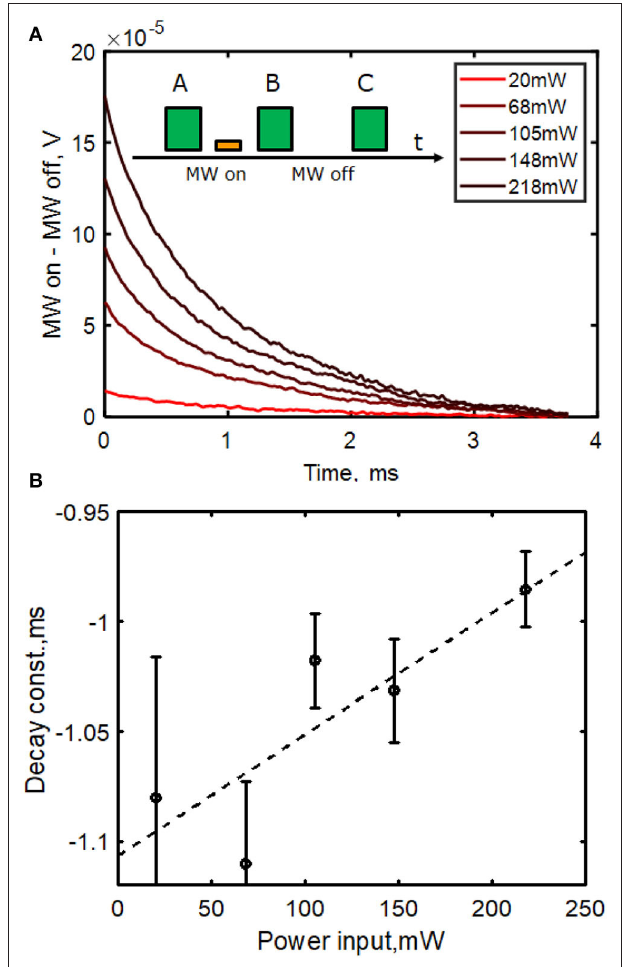
FIGURE 5 | (A) Difference in fluorescence vs. readout pulse time (B,C). The system is initialized with a laser pulse A. Before B a 680 ns π microwave pulse is applied (MW on) and before C, no MW pulse is applied (MW off). The difference in photodetector output voltage during these two pulses as a function of time was measured and the difference is plotted in the figure (MW on-MW off, V). Data is taken at a range of pump laser powers from a Gaussian beam of waist 200 µ m incident at Brewster’s angle. (B) Fitting to an exponential with error estimates based on readout noise. Typical decay length was 1 ms, reducing with higher pump power. This long readout time restricts field sensing bandwidth to 250 or 83 Hz for a 3 pulse, common mode noise mx c coefficients are m = 5.5 rejection scheme. Linear fit (dashed) y = + × 10 − 4 ms/mW and c = 1.1 −